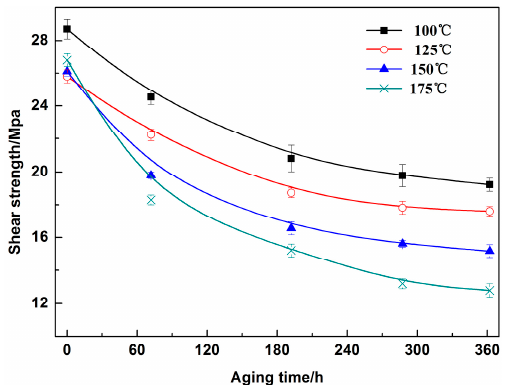
Figure 11. Shear strength of the solder joints for different aging time and temperature.